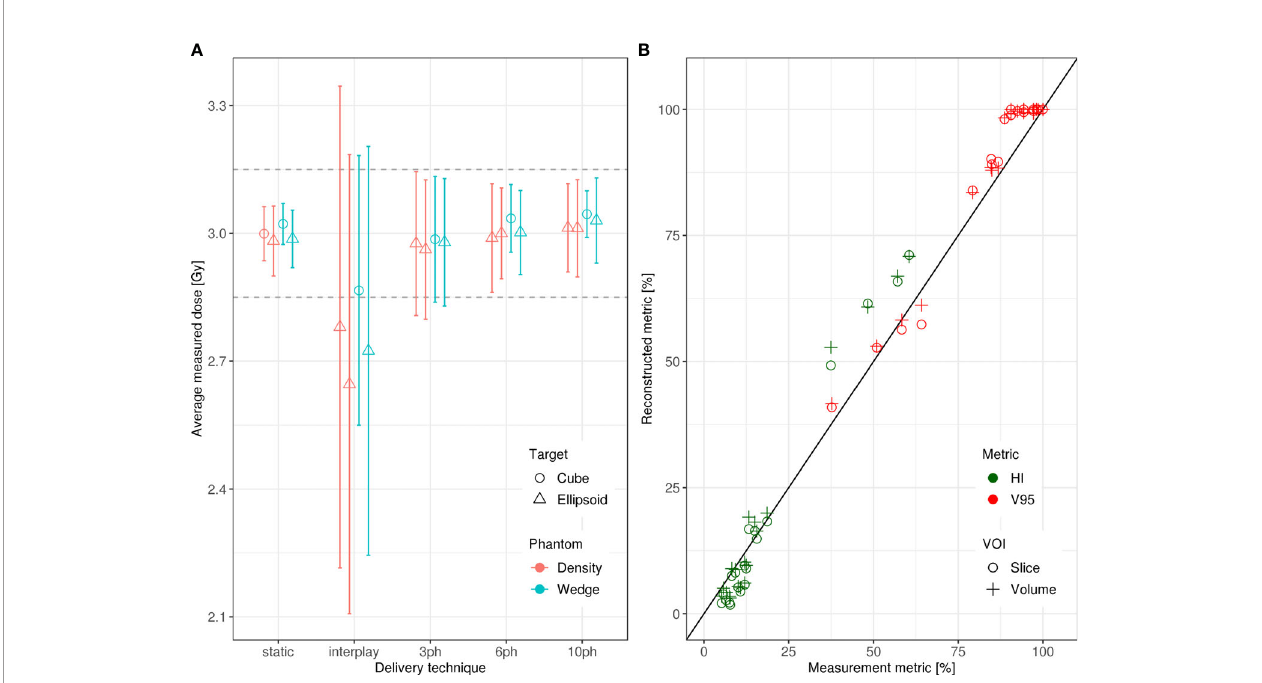
FIGURE 5 | (A) Average measured absorbed dose versus delivery technique evaluated using the density and wedge phantoms. The dashed grey lines delineate the ± 5 % tolerance interval centered about the prescription absorbed dose of 3 Gy and the bars indicate the spread measured dose values from each ionization chamber (IC) of the 2D IC array detector in the clinical target volume (CTV) (B) Homogeneity (HI) and coverage (V 95 ) for measured versus reconstructed absorbed dose distributions in the target volume. Dosimetric quality was calculated in a single iso-energy slice within the CTV and in the entire CTV for each delivery. All delivery techniques for both phantom types and for both VOIs are plotted. Data points that fall on the line indicate full agreement of measured and reconstructed HI and V 95